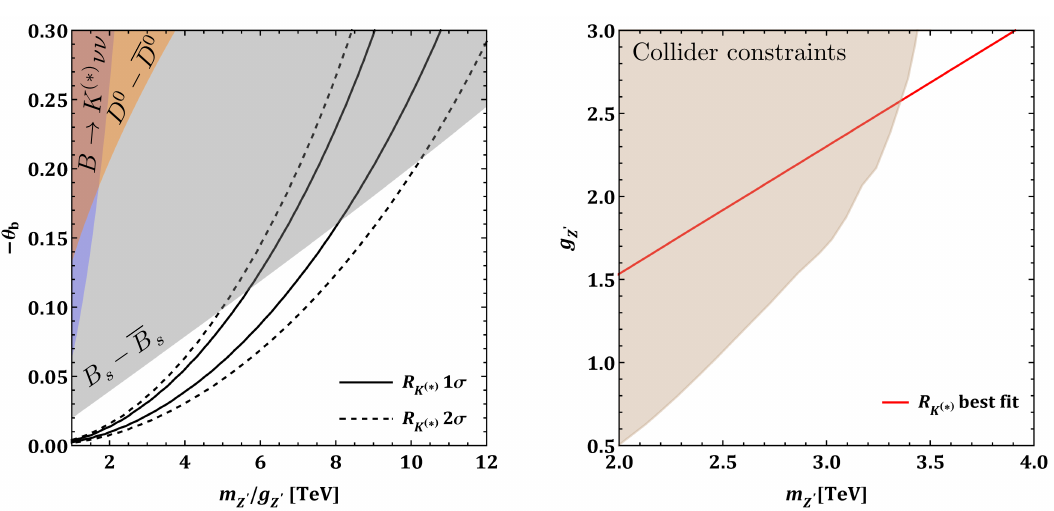
Figure 4 . Left panel : the allowed parameter space of { m observed R anomaly at the 1 σ (solid curves) and 2 σ (dashed curves) levels. The gray-, orange- K ( ∗ ) and blue-shaded regions are excluded by the B the 95% C.L., respectively. Right panel : LHC constraints on the allowed parameters space of m and g by measuring the Drell-Yan process qq → Z 0 → µ + µ − , where the value of θ Z 0 − 0 . 005 . The brown region is excluded at the 95% C.L. and the red line denotes the relation between m and g when ∆ C µ takes its best-fit 9 Z 0 Z 0